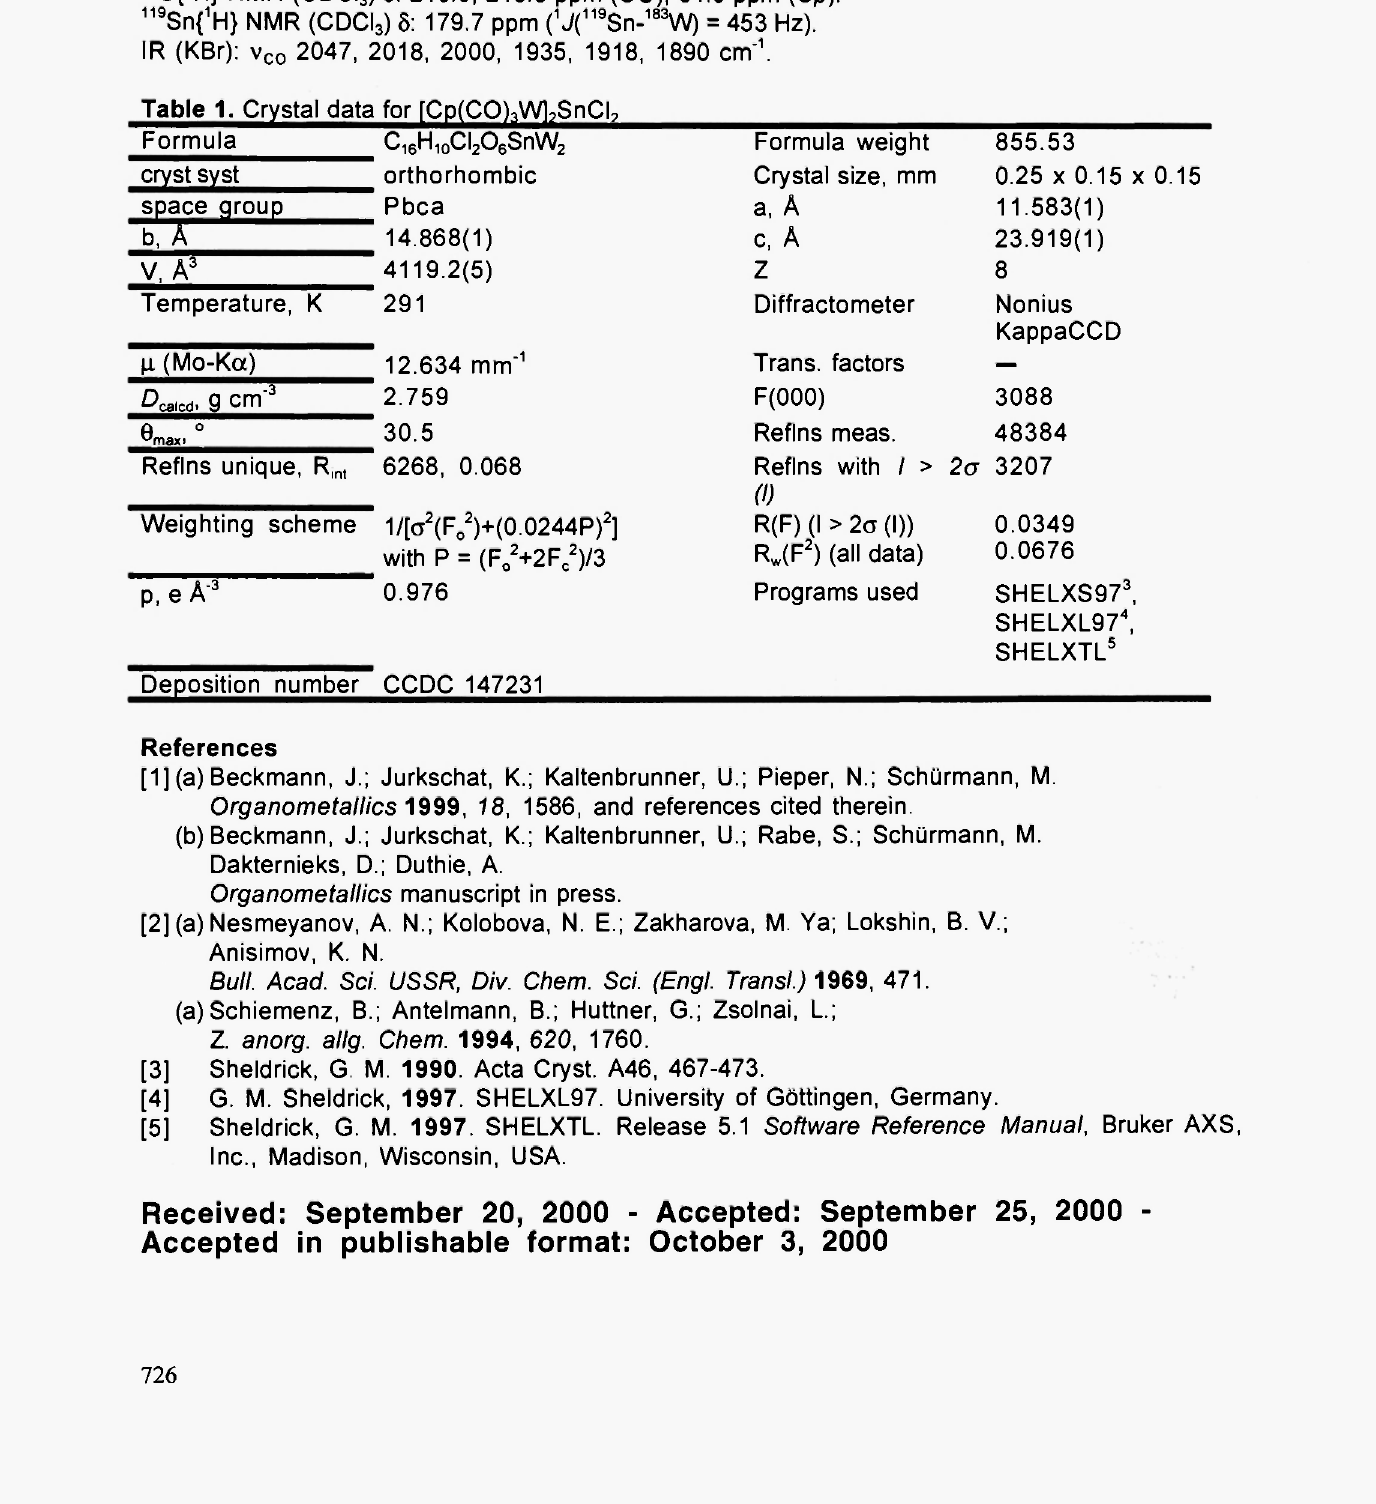
Table 1. Crystal data for [Cp(CO),W1 7 SnCI